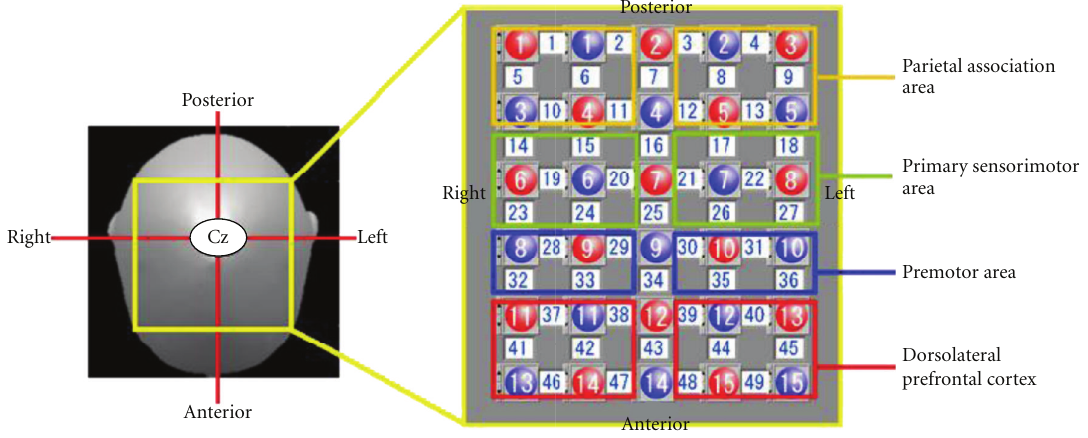
Figure 1: Measurement by functional near infrared spectroscopy. We employed a 49-channel system with 30 optodes. 15 light sources (red numbers) and 15 detectors (blue numbers) that covered the frontoparietal area. Solid white numbers denote measuring channels, which were spread to 8 regions of